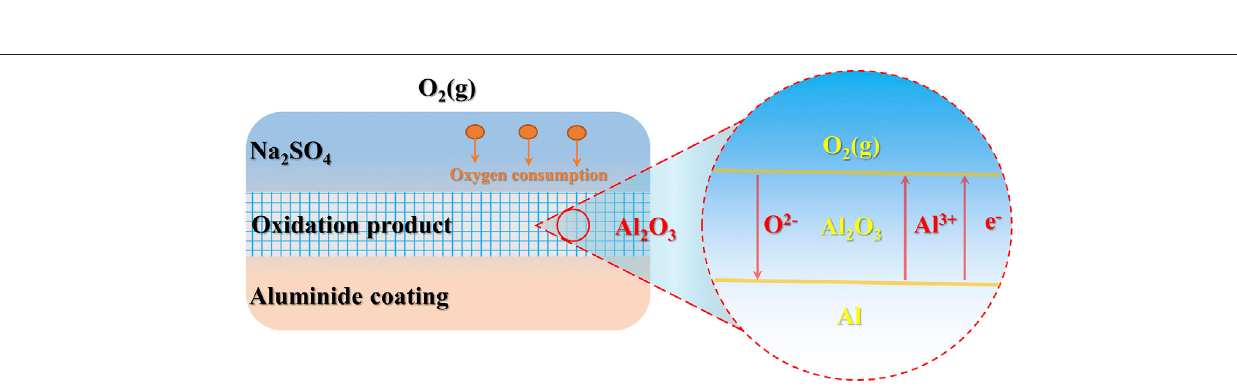
Frontiers in Materials |